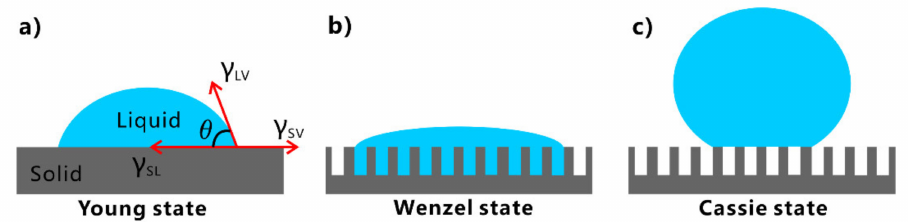
Figure 2. Typical contact states between a liquid droplet and solid surface: ( a ) Young contact state, ( b ) Wenzel contact state, and ( c ) Cassie contact